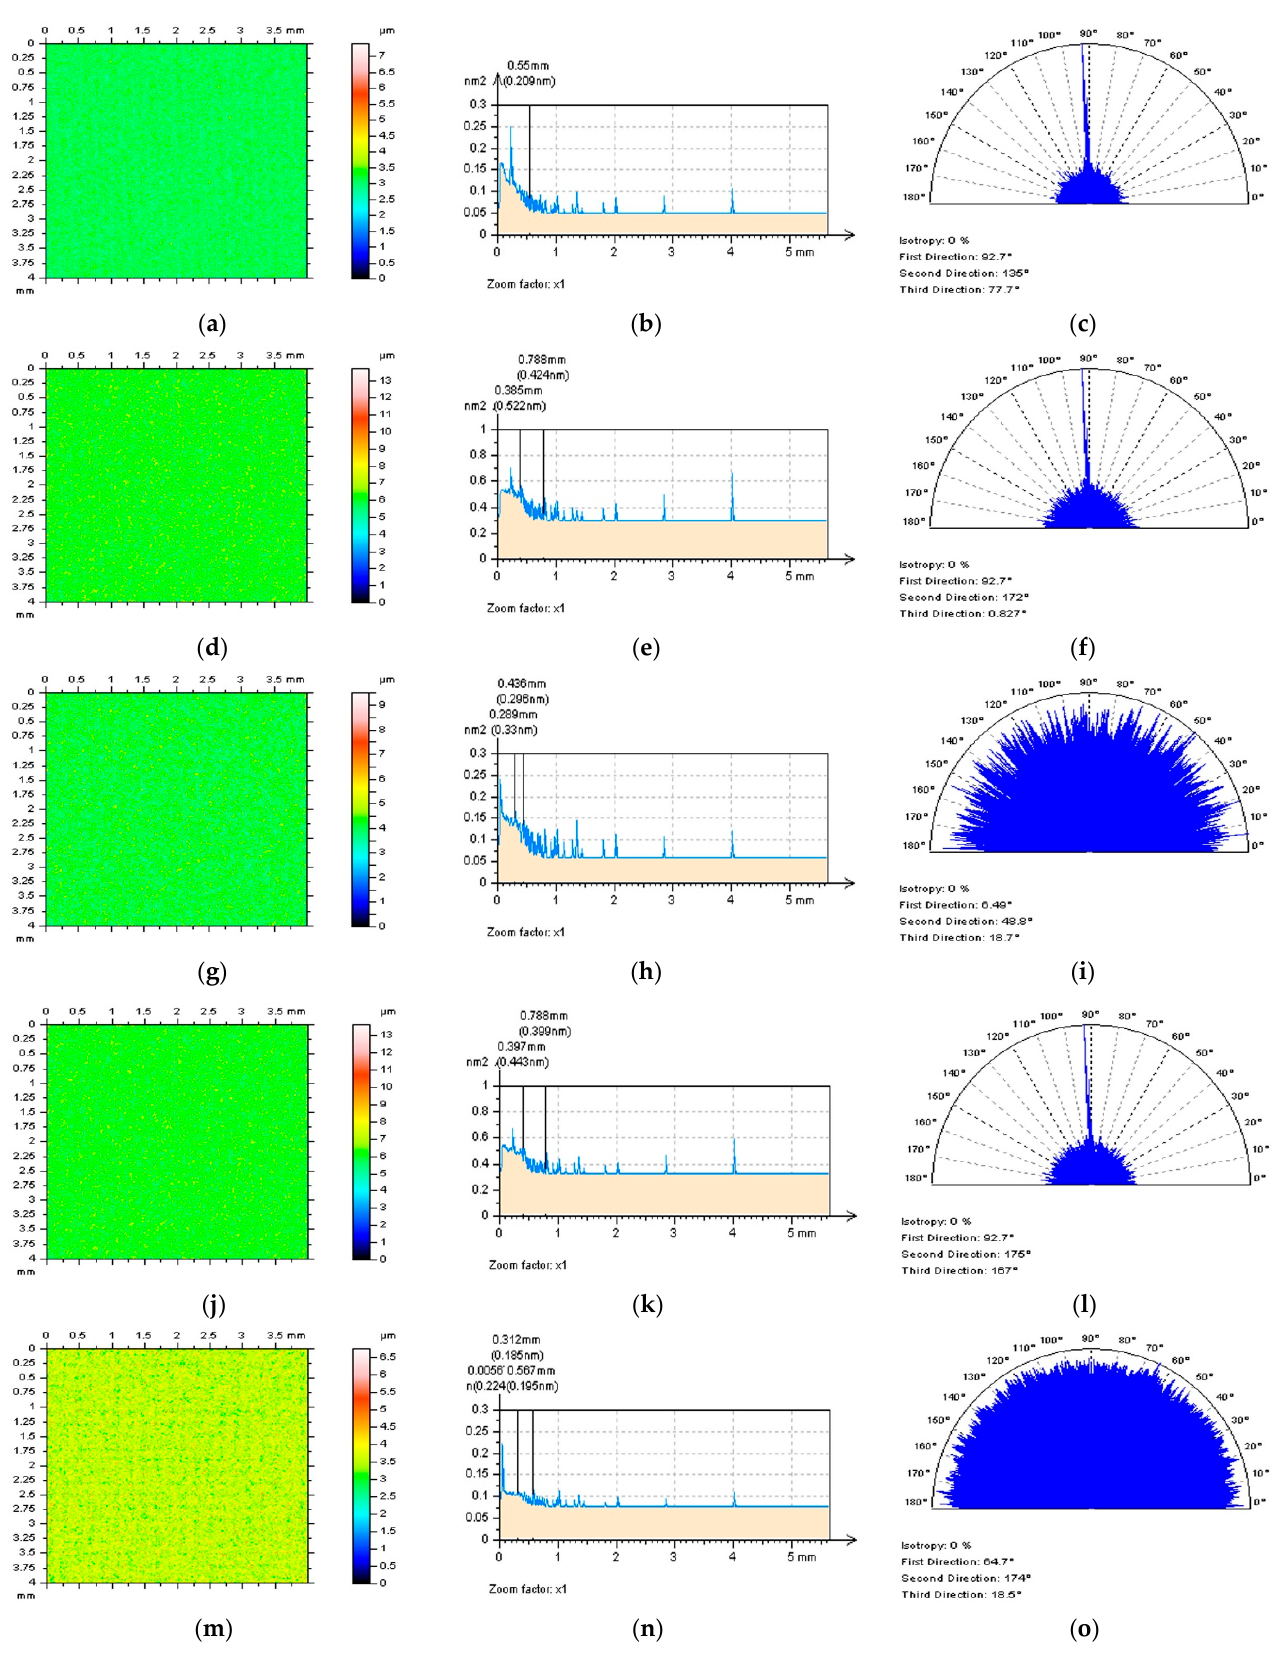
Figure 6. Analysis of a HFNS (left column), their PSDs (middle) and TDs (right column) received from a turned piston skirt surface by application of: GF ( a – c ), RGF ( d – f ), SF ( g – i ), MDF ( j – l ) and FFTF ( m – o ) method, cut–off = 0.025 mm.